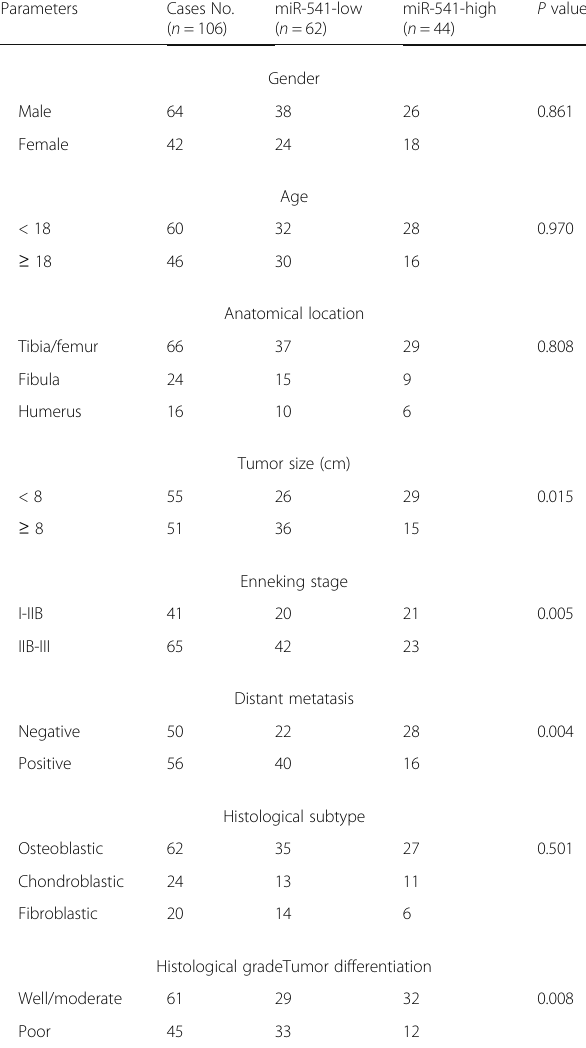
Table 1 Association between miR-541 expression and clinical features in OS patients